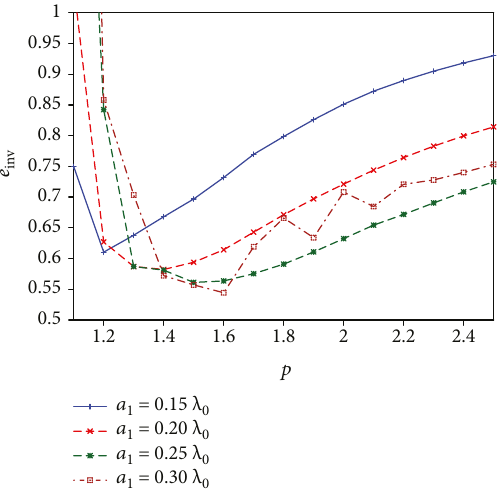
Figure 5: Behaviour of e di ff erent values of the radius a